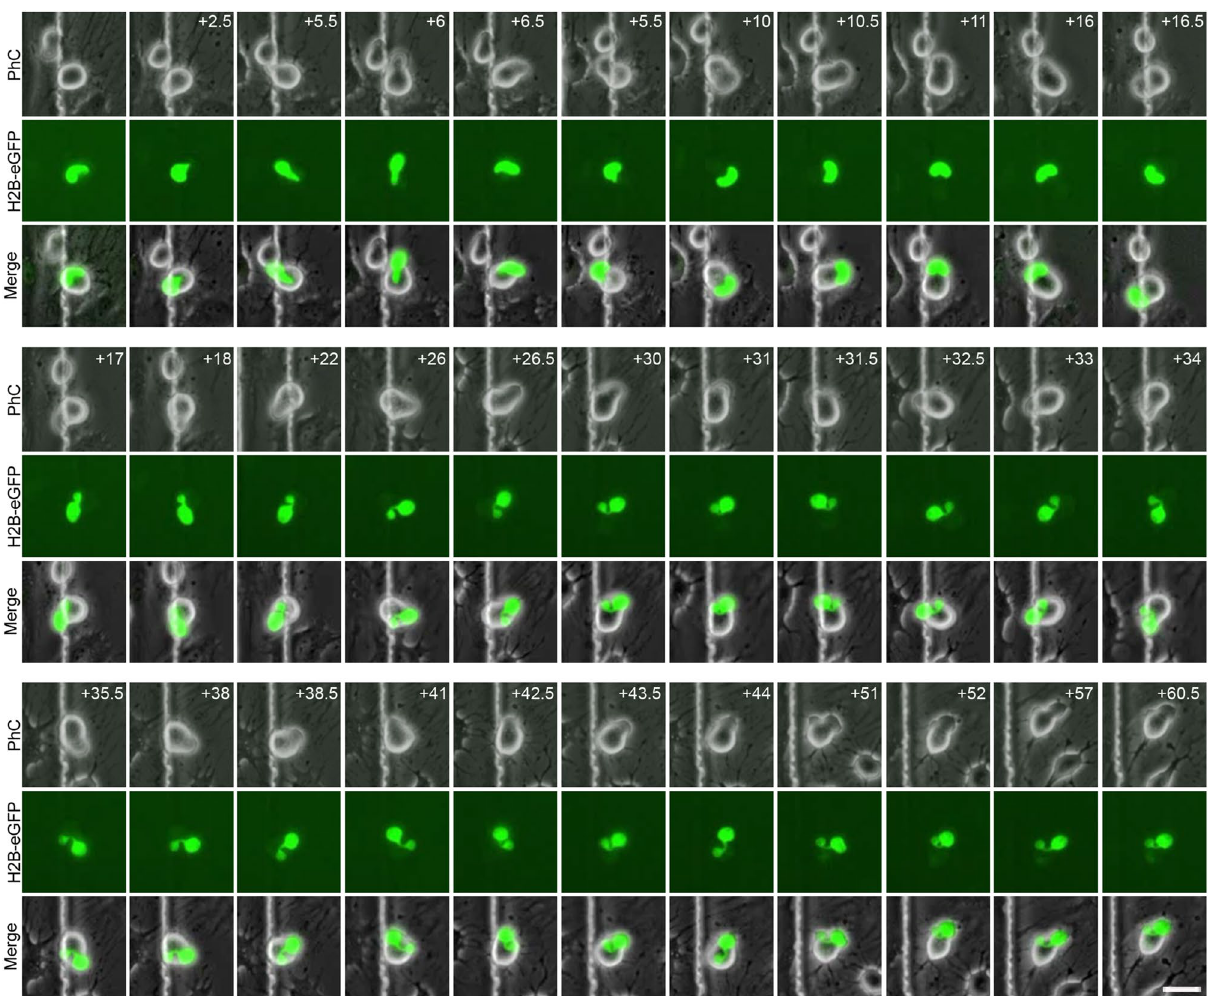
Figure 6. Binucleated hBM-MSCs can form with independence of any cell fusion events. Time-lapse microscopy revealed that the nuclei from histone H2B-GFP-expressing, hBM-MSC-derived intermediate cells can move within the cell, forming lobed nuclei connected by nucleoplasmic bridges. The movement of the lobed nuclei also generated cellular transient protrusions from the surface of hBM-MSC-derived intermediate cells. Scale bar: 25 µm. PhC Phase-contrast